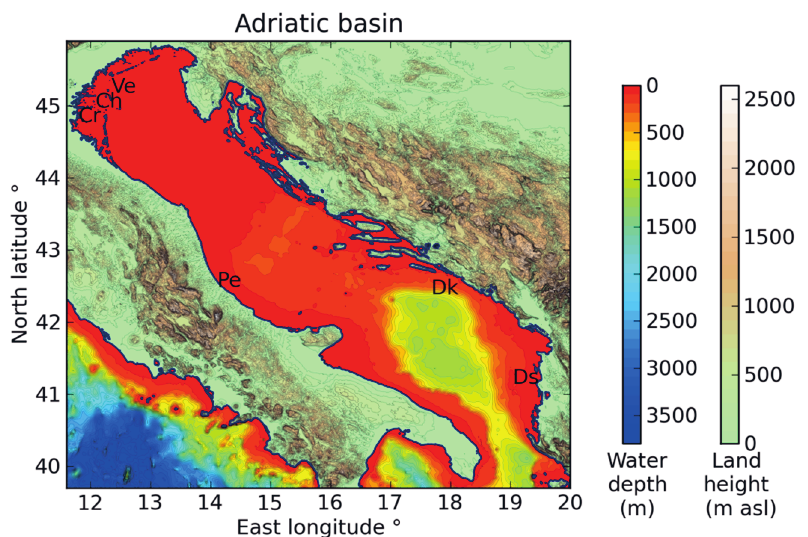
Figure 3. Adriatic Sea domain. The contour interval is 100 m. Ve = Venice; Ch = Chioggia;